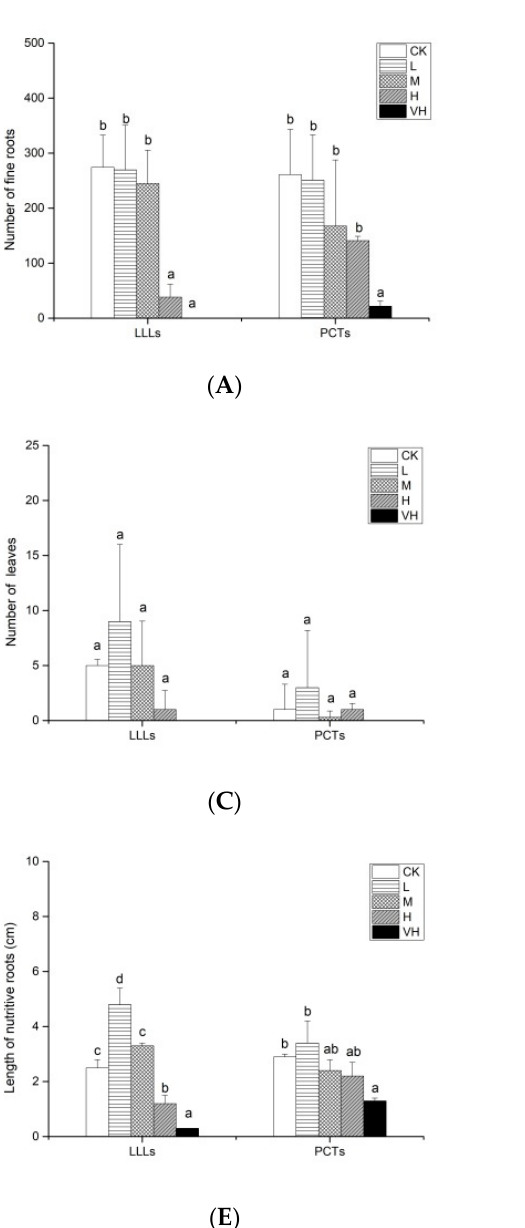
Figure 3. Effects of LLLs and PCTs from K. obovata on numbers of A. corniculatum fine roots, nutritive roots, and leaves and the lengths of A. corniculatum fine roots, nutritive roots, and stems. Young A. corniculatum propagules were exposed to 0 (CK), 2 (L), 10 (M), 20 (H), and 50 (VH) g L − 1 of leaf litter leachates and 0 (CK), 10 (L), 100 (M), 200 (H), and 600 (VH) mg L − 1 of purified condensed tannins based on 10 ppt artificial sea water for 3 months, respectively. Next, the numbers of A. corniculatum fine roots ( A ), nutritive roots ( B ), and leaves ( C ) and the lengths of A. corniculatum fine roots ( D ), nutritive roots ( E ), and stems ( F ) were evaluated and compared using the LLLs and PCTs of K. obovata treatments. Single letters (a, b, c, and d) represent significant differences among groups ( p < 0.05). Double letter ab denotes no significant difference with a or b. Each column ( ± SD) represents the mean of three individual A. corniculatum